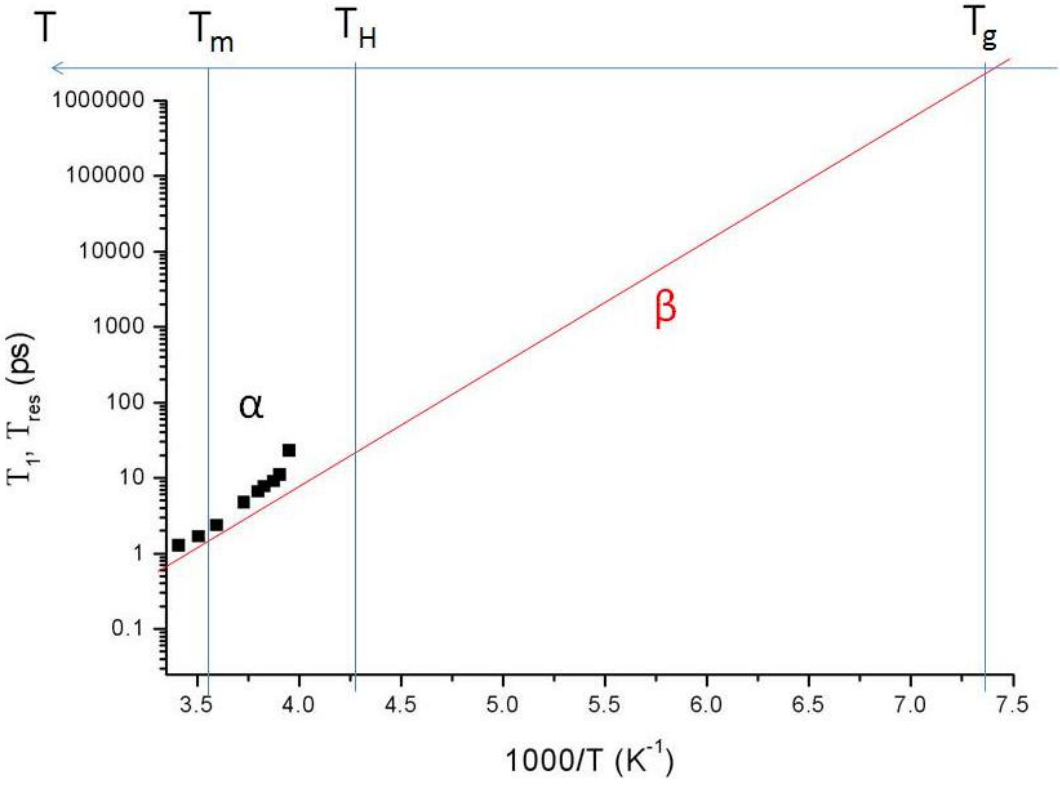
Figure 1. Schematic Arrhenius representation of some dynamic processes in supercooled water. The α line represents the strongly non Arrhenius behavior of the transport properties of water. Squares are residence times, T , obtained from neutron scattering experiments at res temperatures above −20 °C [19,20,22]. The solid line represents β processes, in this case, the dynamics of hydrogen bond dynamics which follow an Arrhenius temperature dependence. Above −20 °C this characteristic time, T , is obtained from the same experimental 1